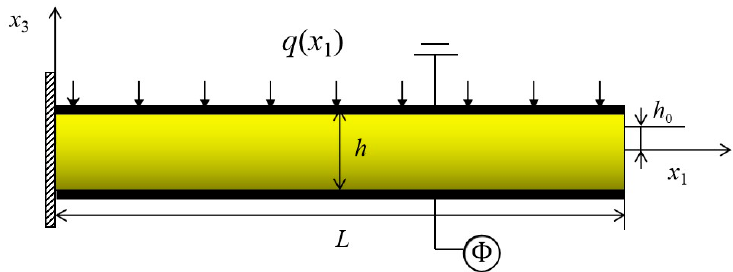
Figure 1. The geometry and coordinates of an FGM piezoelectric cantilever beam.